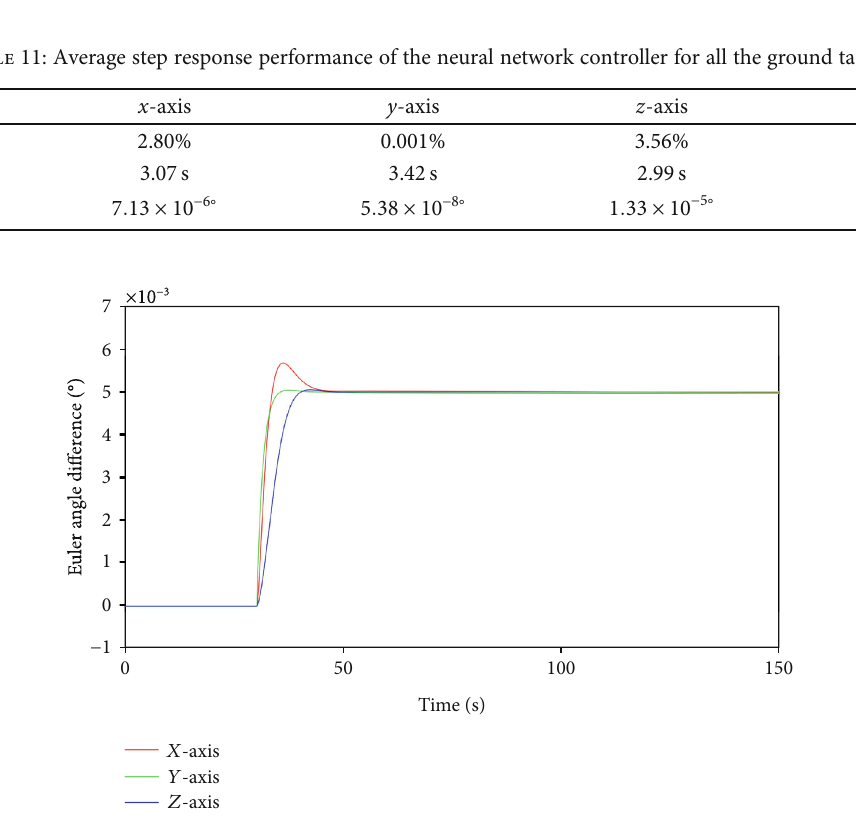
Figure 11: Step response of the PID controller when the satellite stares at the central ground target.